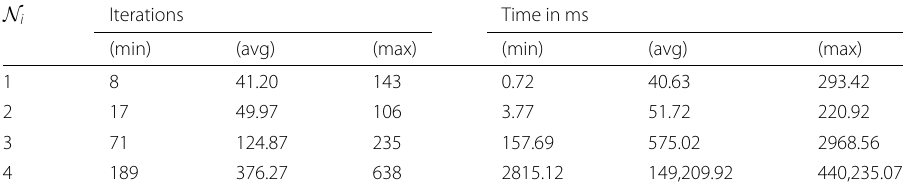
Table 1 Performance indicators of the Negative Cycle Algorithm, where Columns 2 to 4 represent numbers of iterations and Columns 5 to 7 show the running times in milliseconds N